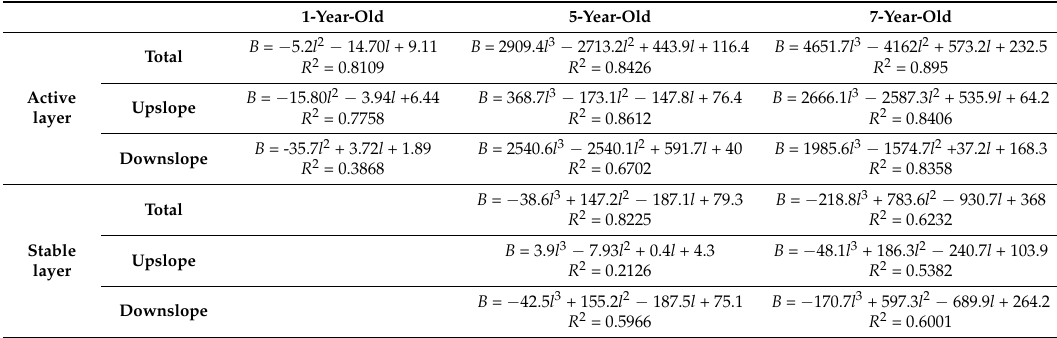
Table 7. Regression equations and R 2 values for the variation of the root biomass with the distance from the stem in the horizontal direction.